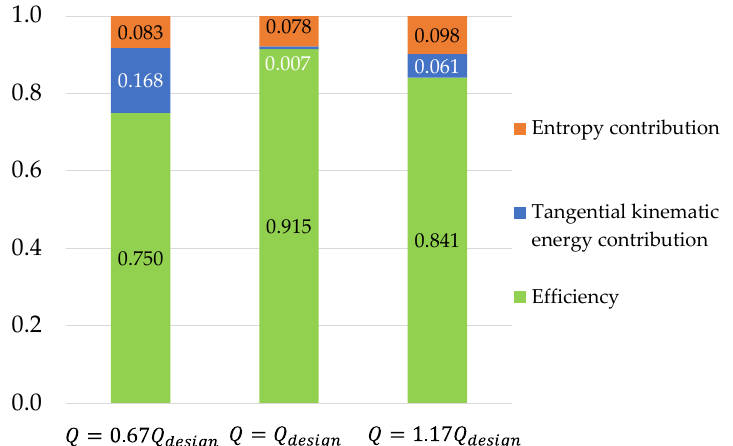
Figure 18. Comparison of main loss contributions and efficiency for three different flow rates at design rotational speed— H n = const .